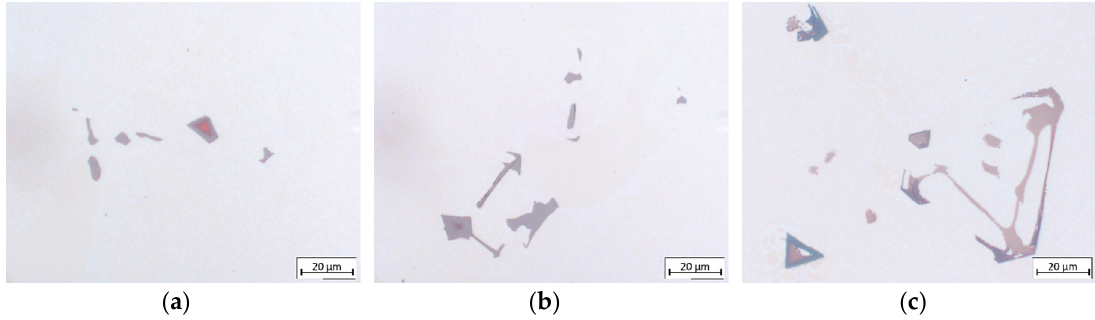
Figure 5. Morphology of carbides in TC-SC samples of: ( a ) CMSX-6; ( b ) CMSX-6 + 0.03C; ( c ) MAR-M247 directionally solidified at 0.13 K · s − 1 .